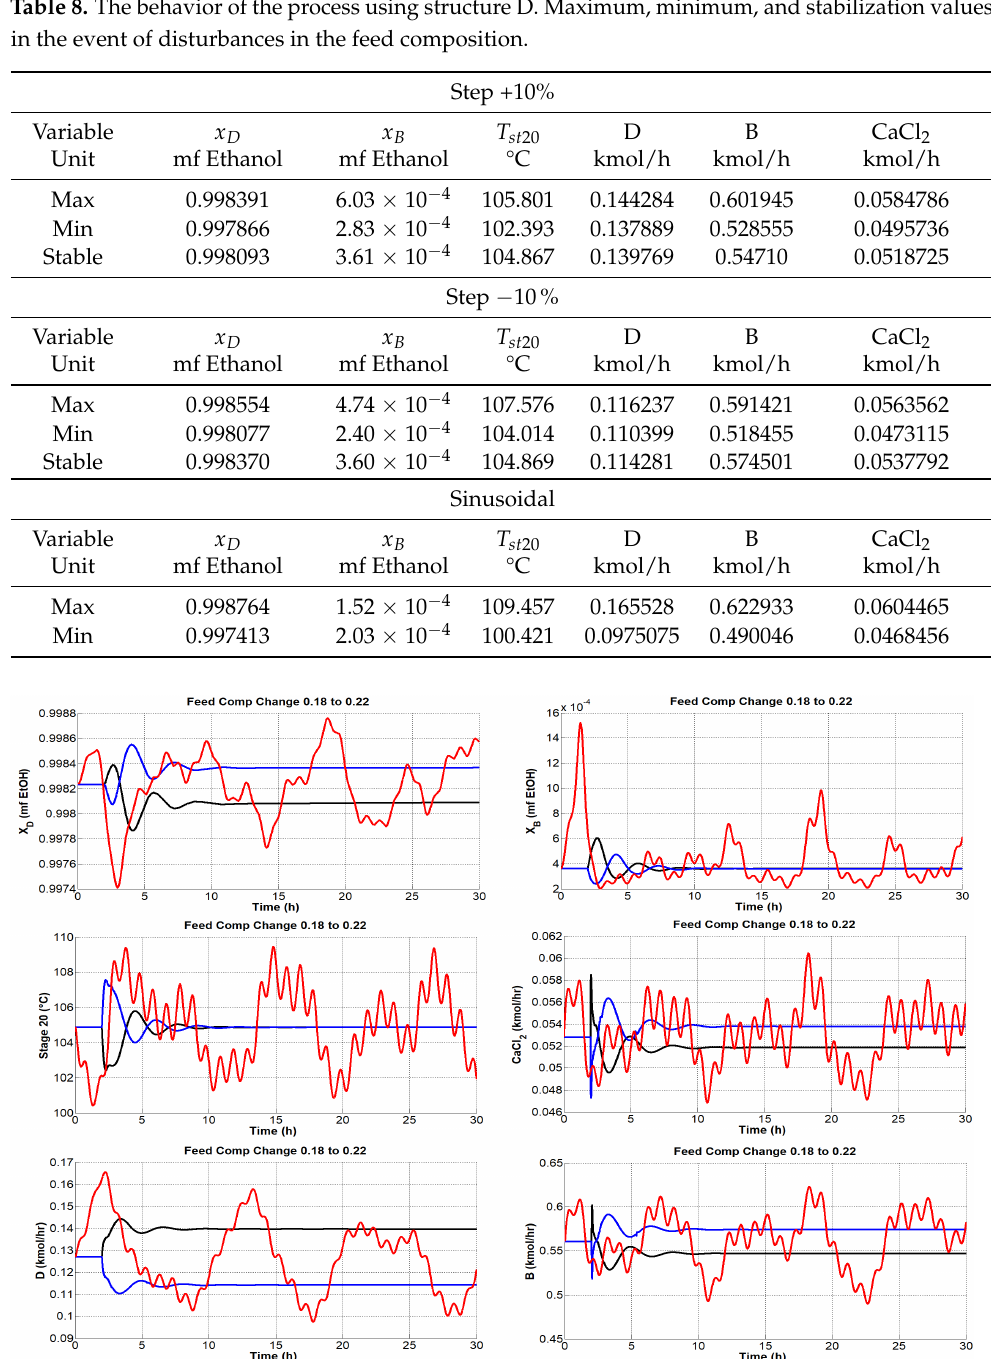
Figure 14. The behavior of structure D with changes in the main feed in a stepwise form of 10% mf ( black ) and − 10% mf ( blue ), also sinusoidal changes in the mole fraction ( red